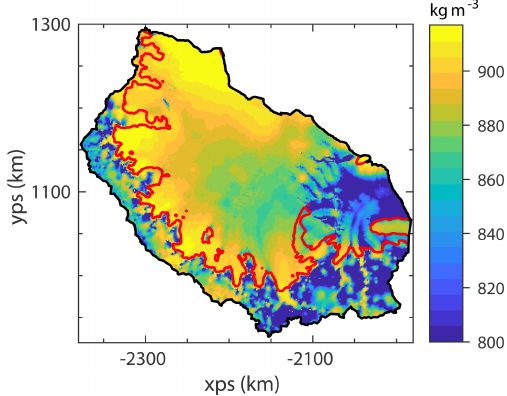
Figure D1. A map of the depth-integrated, spatially variable ice density (with a minimum ice density of 800kgm − 3 ) as used in the main experiments in this study. The red line shows the grounding line and the black line the boundary of the model